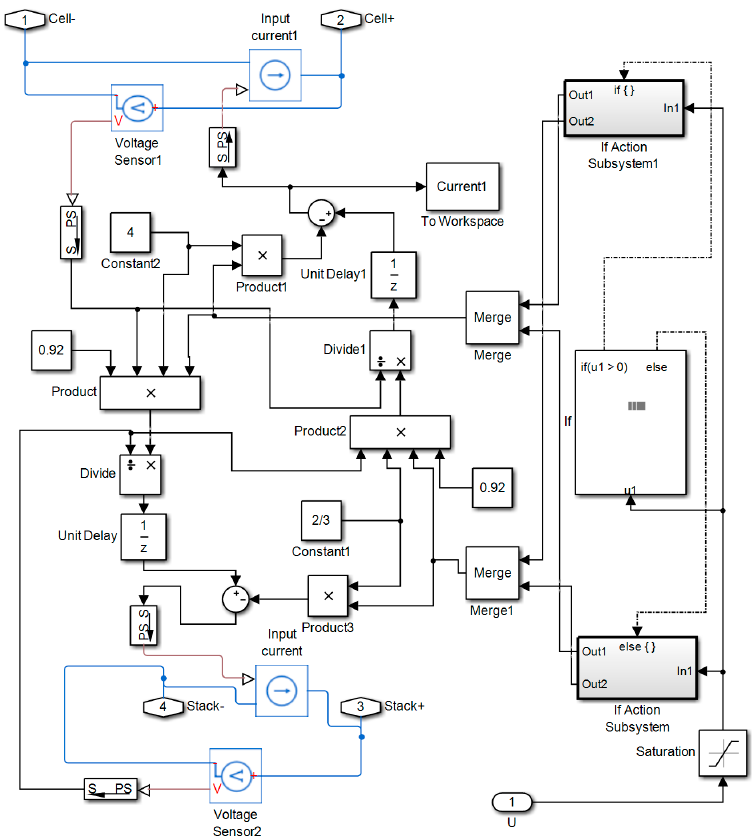
Figure 21. DC–DC simulation model.